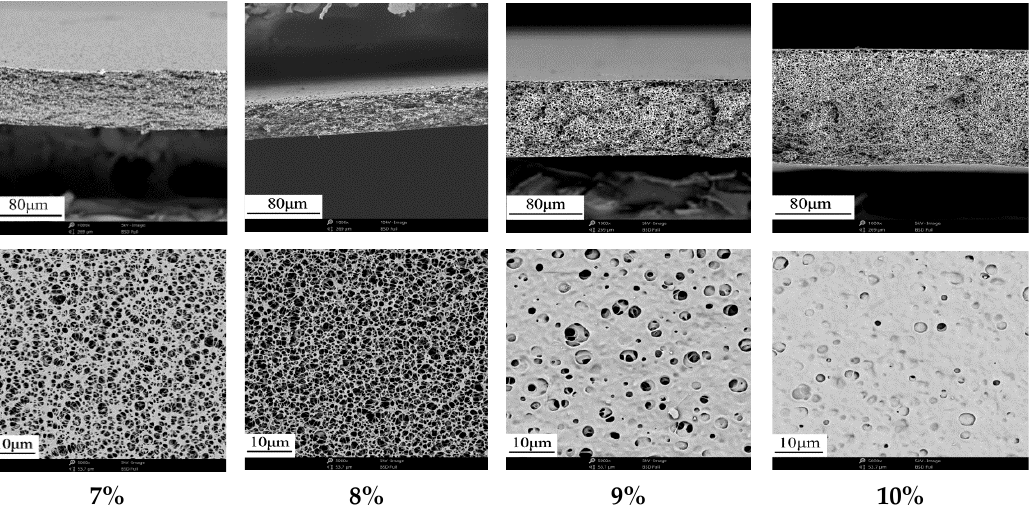
Figure 2. Effect of CA content on the cross-section and surface microstructure of membranes. Table 3. The properties of membrane prepared under different CA content